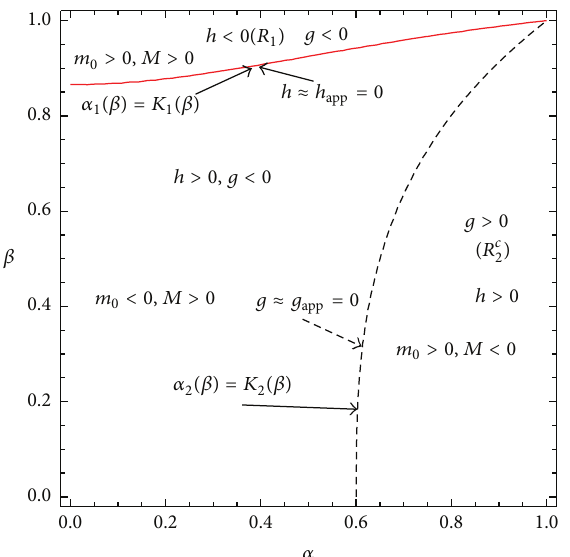
Figure 2: CC regions in trapezoidal 5-BP with four equal masses and a varying central